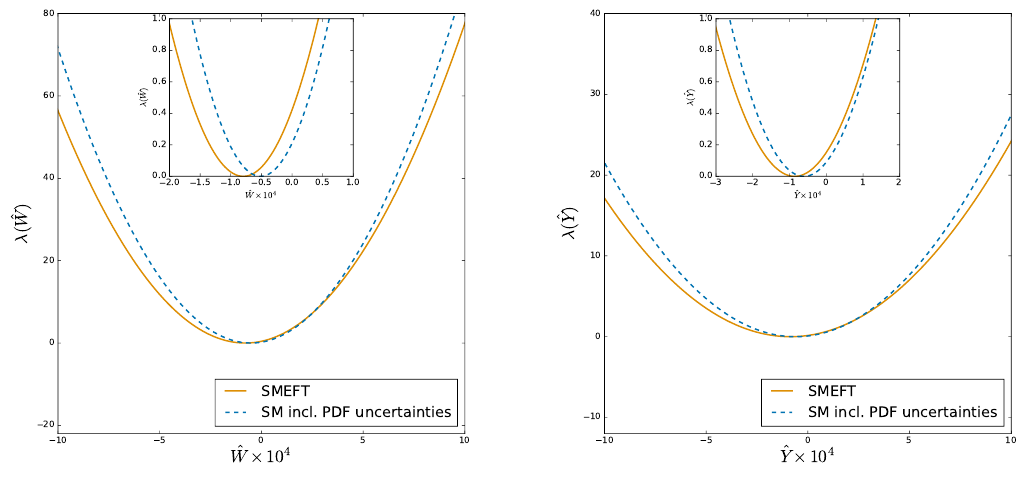
) as compared to the SM PDF eftp